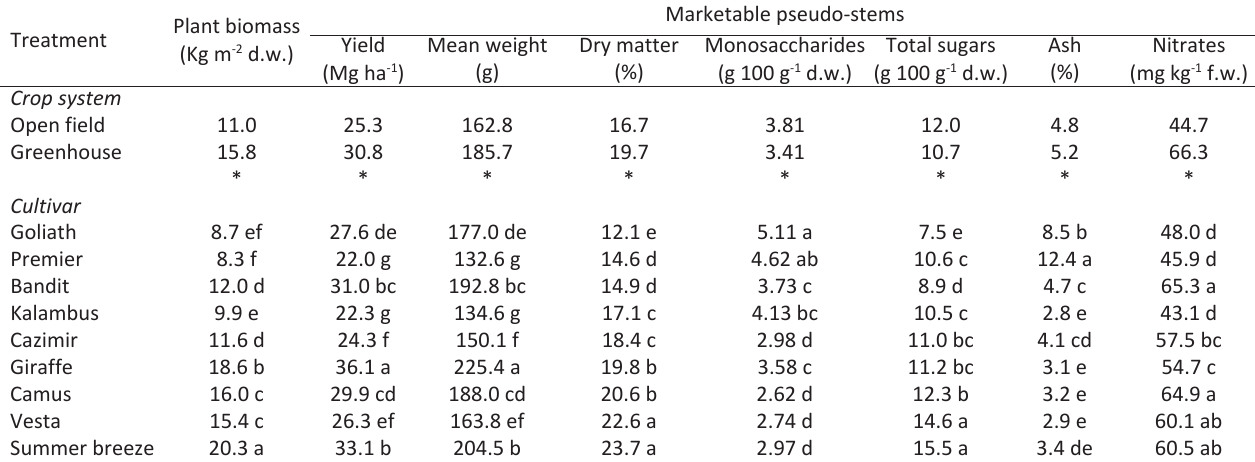
* significant at P≤0.05. Within each column, means followed by different letters are significantly different according to Duncan test at